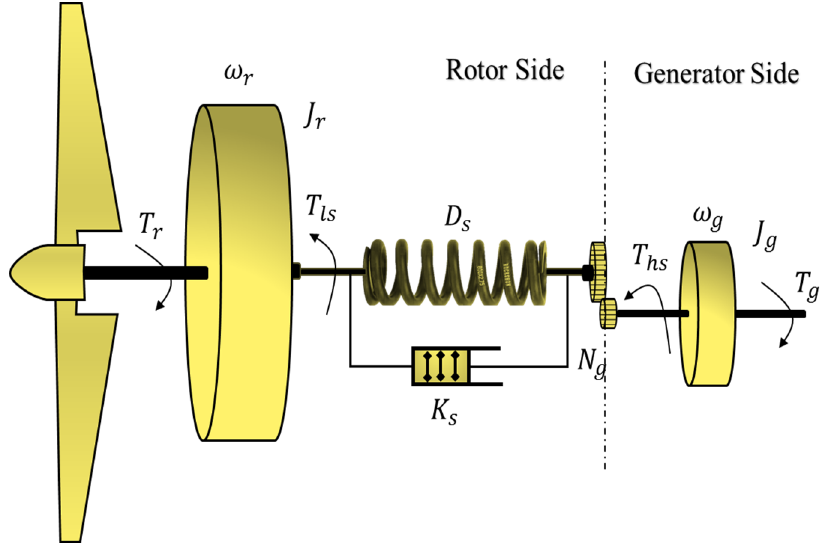
Figure 1. Structure of a typical wind turbine [28].